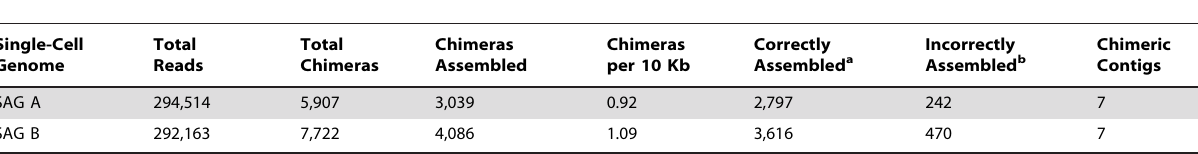
Table 2. Chimera formation rates and impact on de novo genome assembly of 454-FLX reads.